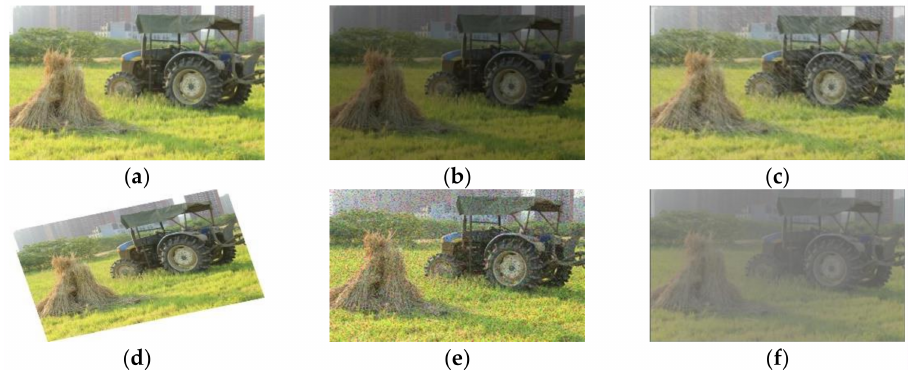
Figure 3. Original image and its expansion processing. ( a ) original image; ( b ) random brightness; ( c ) rainy processing; ( d ) random rotation; ( e ) Gaussian noise; ( f ) atomization processing.